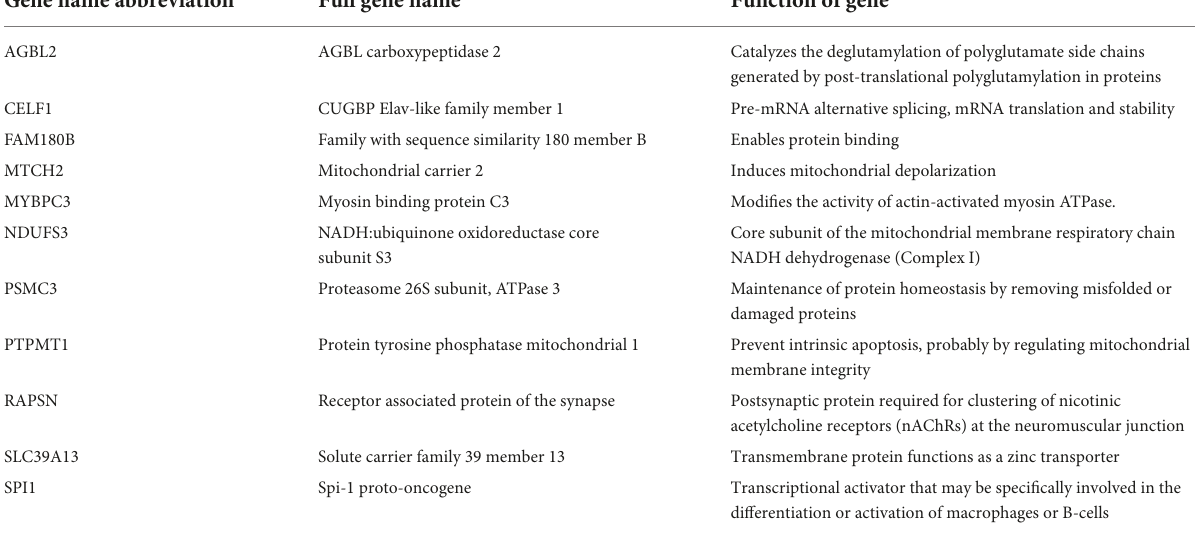
TABLE 2 Shared genes between AD and